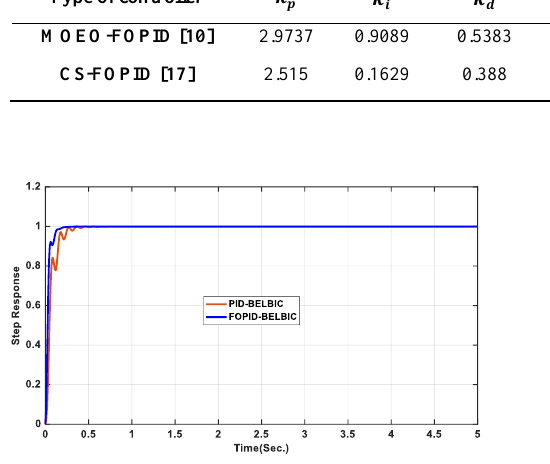
Figure 8. Step response of the AVR system using FOPID- BELBIC and PID-BELBIC. Table 2. Comparison of FOPID-BELBIC and PID- BELBIC. Type of controller